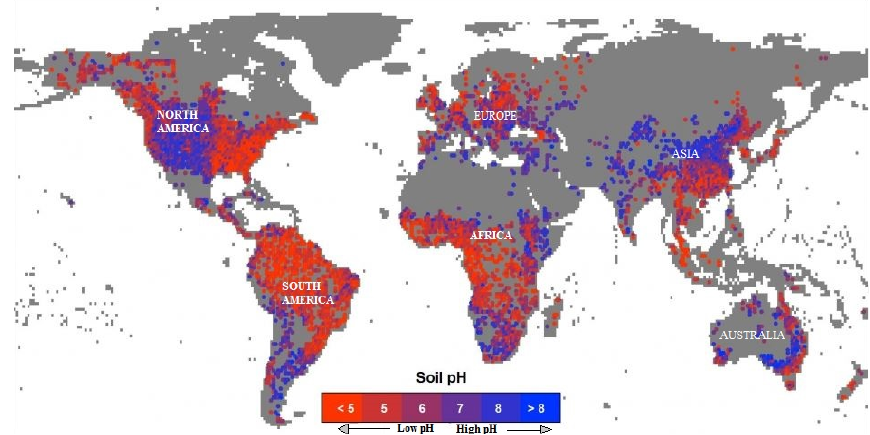
Figure 1. World distribution of soil pH (modified from [25]).